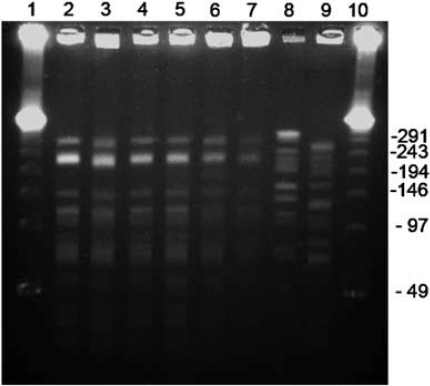
PFGE patterns of SmaI-digested DNAs of vancomycin-resistant Enterococcus faecium. Lane 1 and 10, molecular sizes are shown in kilobases; lane 2, patient 1 (8045), lane 3, patient 2 (8890); lane 4, patient 3 (8956); lane 5, patient 4 (1318); lane 6, environmental strain 1 (6318); lane 7, environmental strain 2 (6319); lane 8, unrelated patient strain 1 from another hospital (301036); lane 9, unrelated patient strain 2 from another hospital (304631).